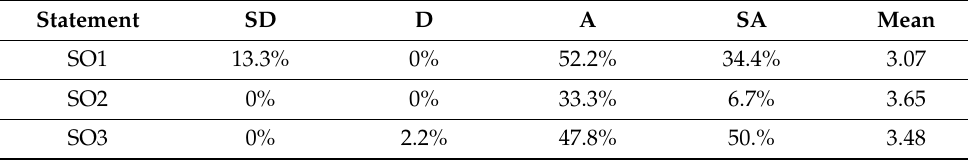
Table 8. Effect of the COVID-19 epidemic on students’ objectives.